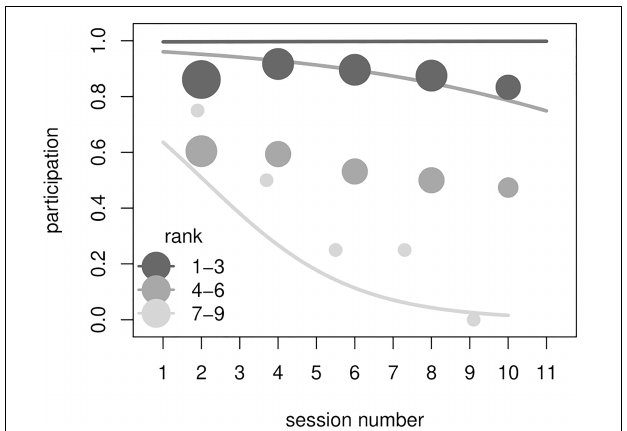
FIGURE 1 | Overall probability to retrieve the familiar (blue) or novel (red) food when both types of food were equally available in conditions A and B in the first (up to) 10 retrieval episodes for each subject and condition. Probabilities were estimated according to coefficients of model M1 (see Table 2 ), keeping all non-significant predictors at their sample mean.